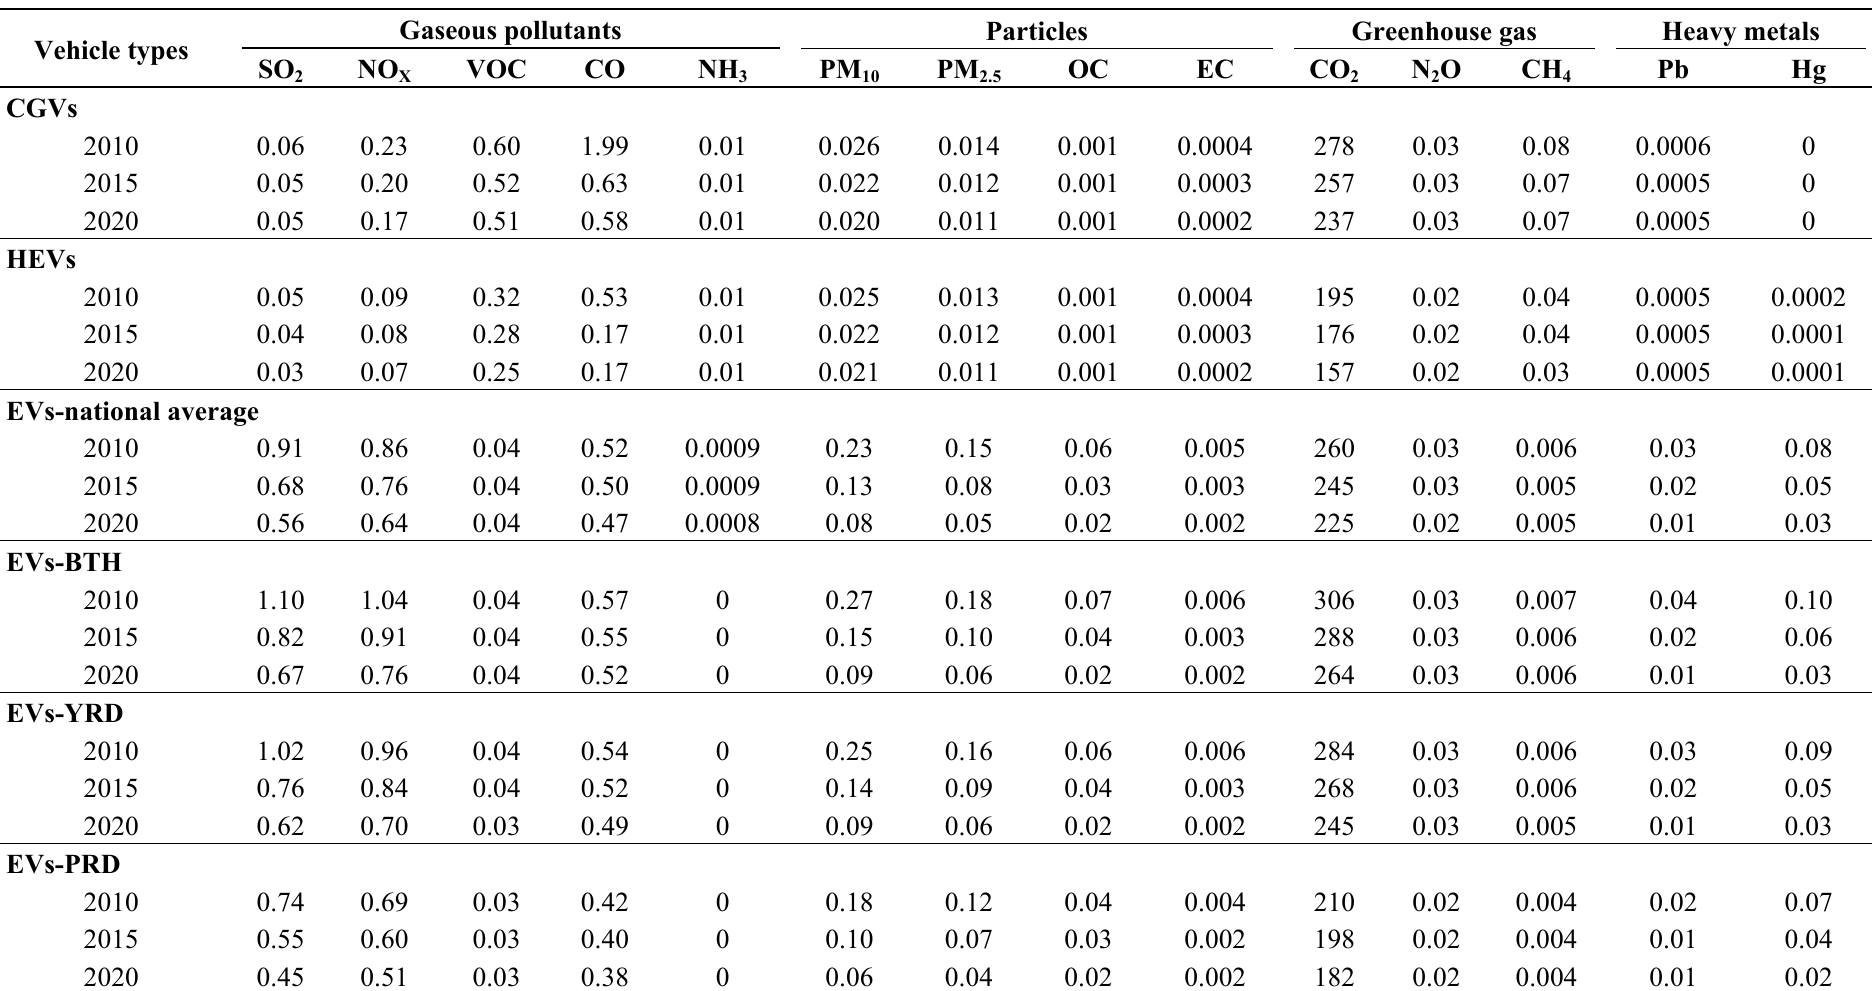
Table 10. Emission factors of CGVs, EVs and HEVs (g/km, mg/km for heavy